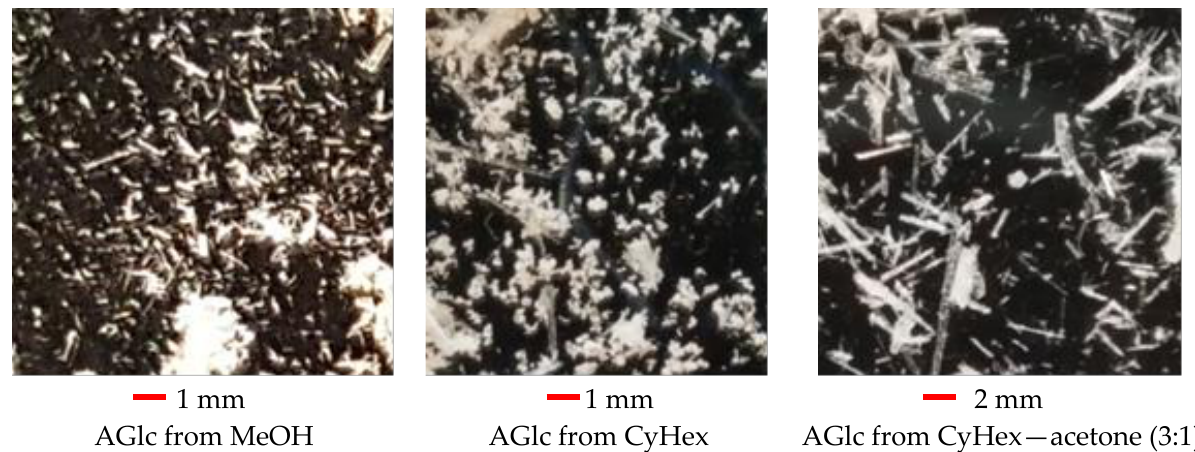
Figure 3. Crystal morphology observed for AGlc crystallised from the solvents: methanol, cyclohexane, and the mixture of cyclohexane – acetone (v:v; 3:1).